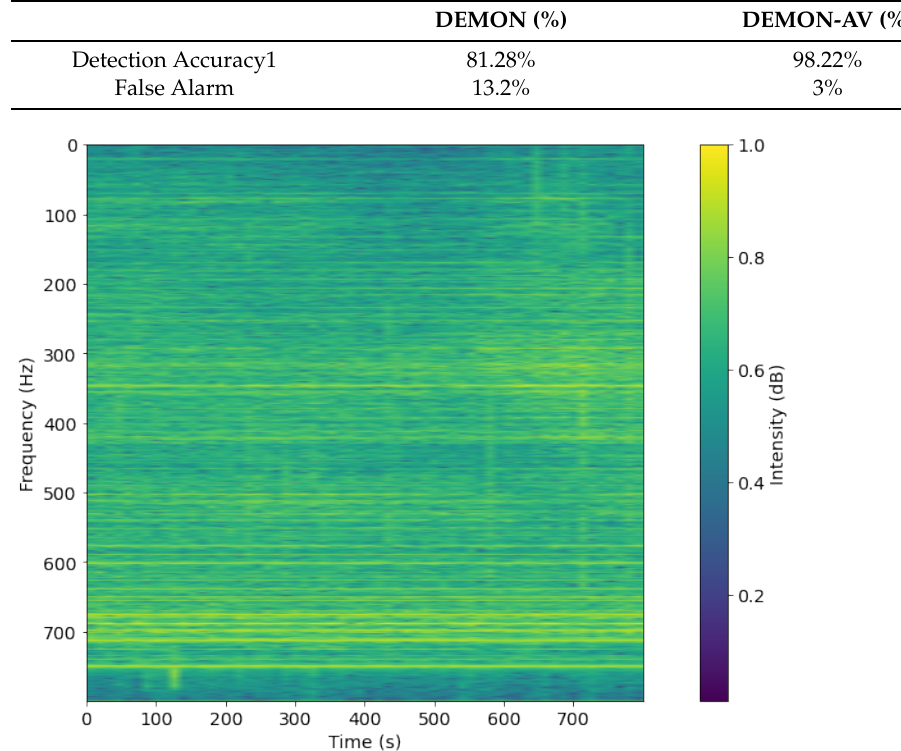
Table 2. Accuracy rates and also the false-alarm rates.